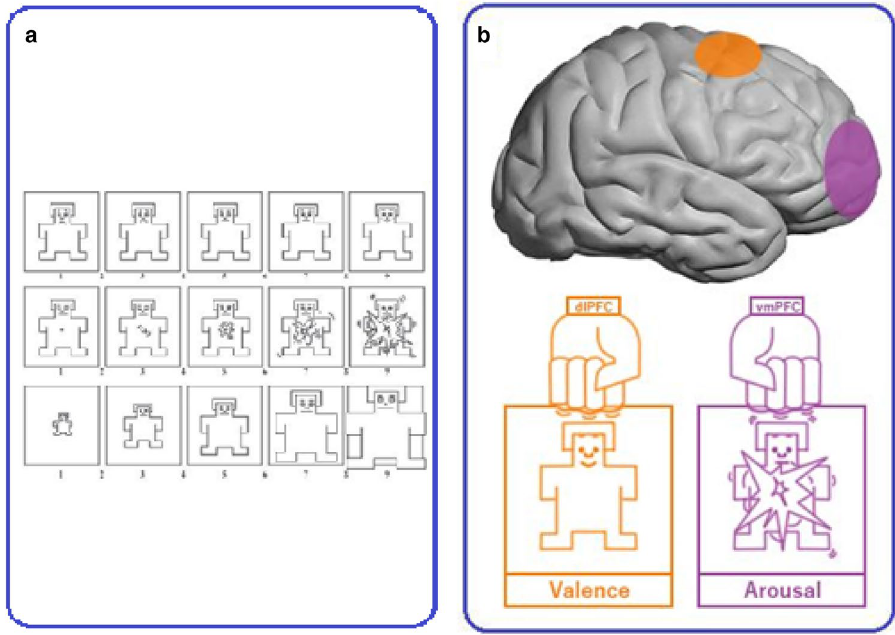
Figure 1. ( a ) The SAM scales for rating stimulus valence, arousal, and dominance, in order from top to bottom; ( b ) a schematic diagram for the effect of the dlPFC and vmPFC on the valence and arousal based on the findings of the present study. Abbreviations: dlPFC: dorsolateral prefrontal cortex, vmPFC: ventromedial prefrontal